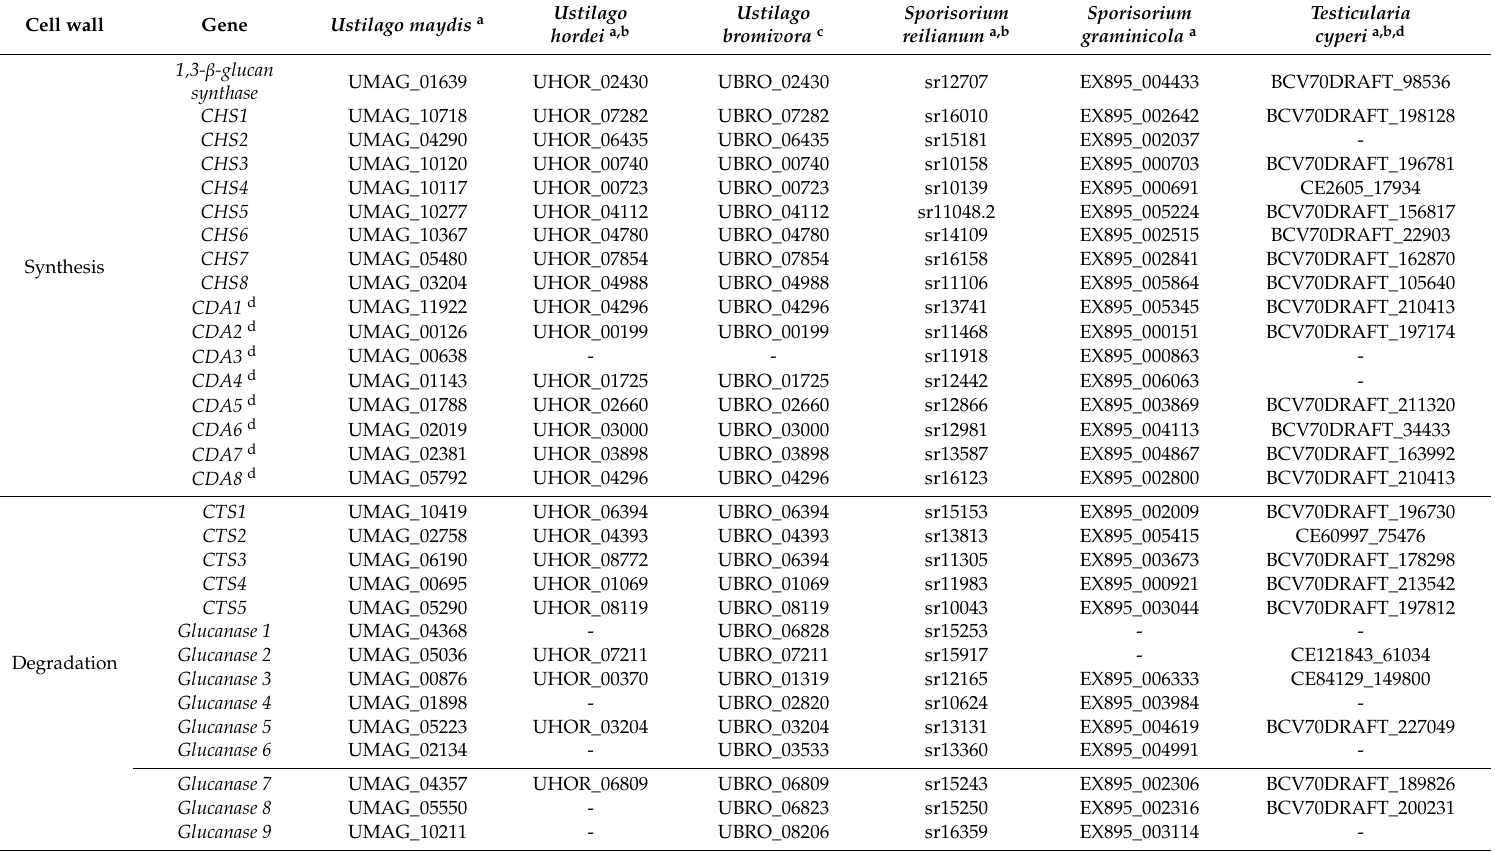
Table 4. Genes involved in synthesis and degradation of the cell wall, and putatively involved in the Ustilaginomycetes multicellular growth. Cell wall